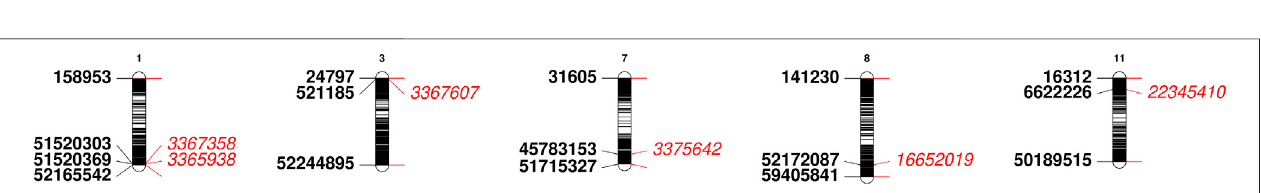
Frontiers in Genetics |